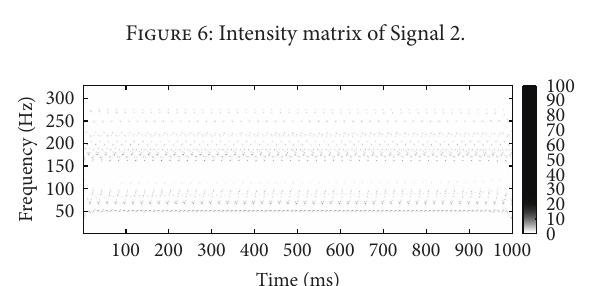
Figure 7: Intensity matrix of Signal 3.